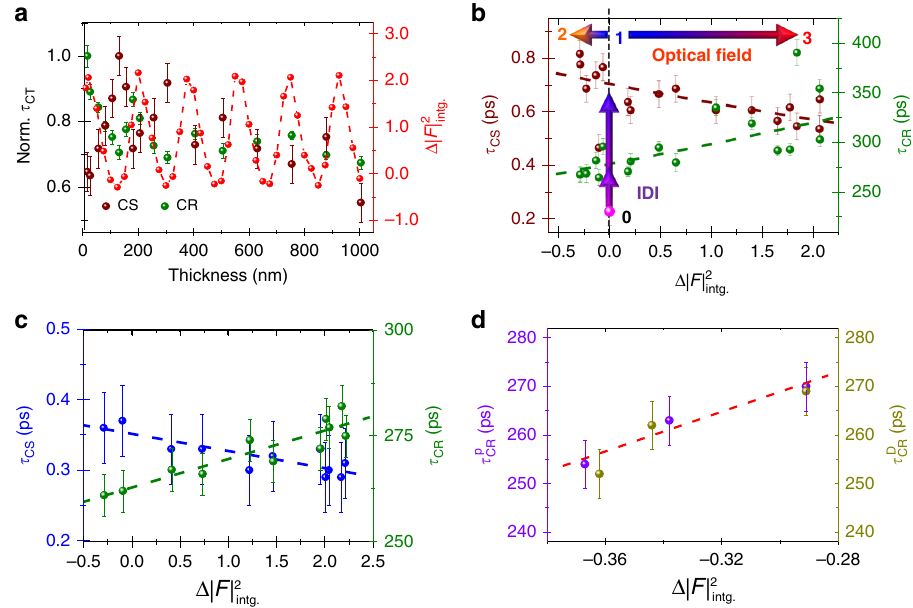
Fig. 6 Analysis of charge-transfer-dynamic-nanophotonic control by nonlocal enhanced optical- fi eld effects. a Variations of charge separation (CS, ) and charge recombination (CR, ) normalized dynamics and integral of the optical fi eld ( ) as a function of the Al 2 O 3 -top-layer thickness. b Linear charge separation (CS: ) and recombination (CR: ) dynamics dependence with the integral of optical fi eld intensity of a 725-nm-incident beam across the organic Donor:Acceptor thin fi lms on top of 4p-composite nanostructures. The bottom pink data points were obtained on fused silica substrate, the vertical and horizontal arrows materialize nonlocal image-dipole-interaction (IDI) effects and nonlocal enhanced optical- fi eld effects, labeled (0), (1) and (2-3), respectively. c Linear charge separation (CS: ) and recombination (CR: ) dynamics dependence with the integral of 725 nm optical fi eld intensity across the organic Donor:Acceptor thin fi lms on top of 200-nm-Ag-composite nanostructures. d Charge-recombination dynamics plotted against the integral of 725-nm-optical- fi eld intensity for different probe-beam powers (CR-P: ) and diameters (CR-D: ) measured on top of Ag-Al 2 O 3 composite nanostructures covered with 125 nm thick Al 2 O 3 . The dashed lines are a